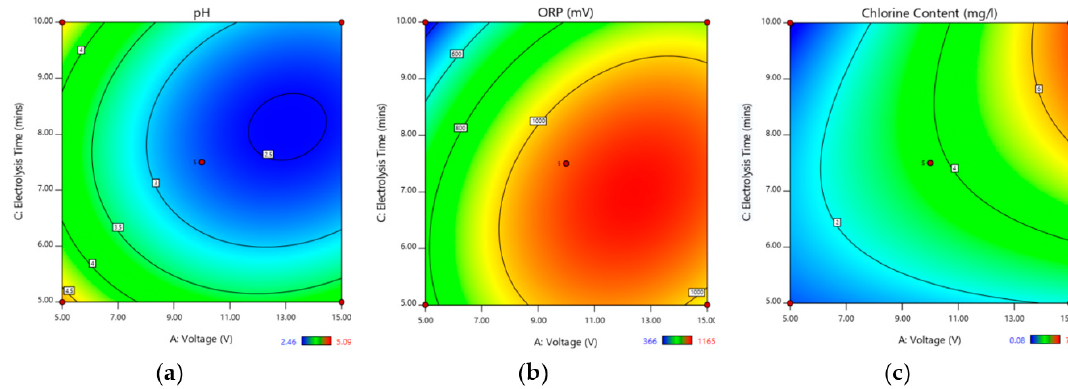
Figure 5. Response surface plot showing the effects of the electrolysis time and the voltage of AcEW on the ( a ) pH; ( b ) ORP and ( c ) chlorine content. Processes 2020 , 8 , x FOR PEER REVIEW